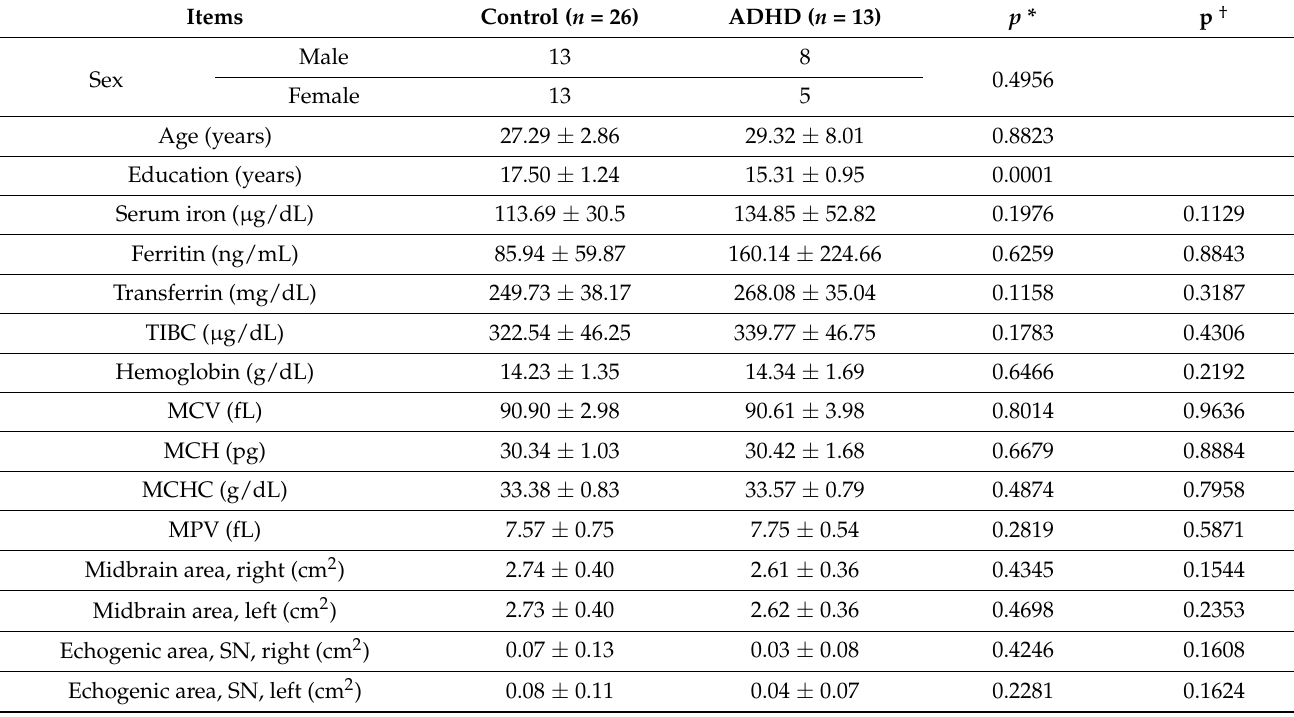
Table 1. Demographic and clinical characteristics of attention-deficit/hyperactivity disorder (ADHD) and healthy con- trol groups.